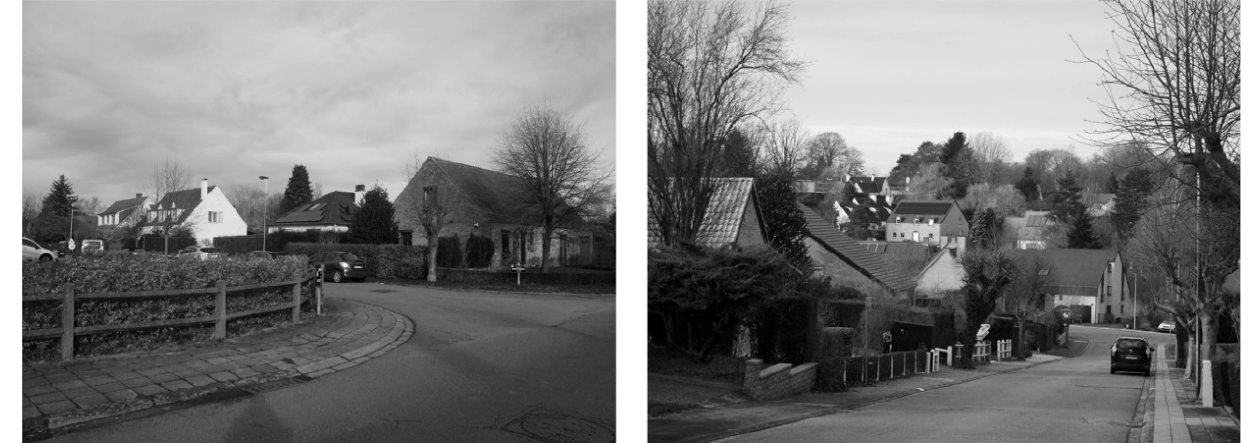
Figure 6. Urbanization in the Winterberg Avenue in Rixensart. Photographs by the